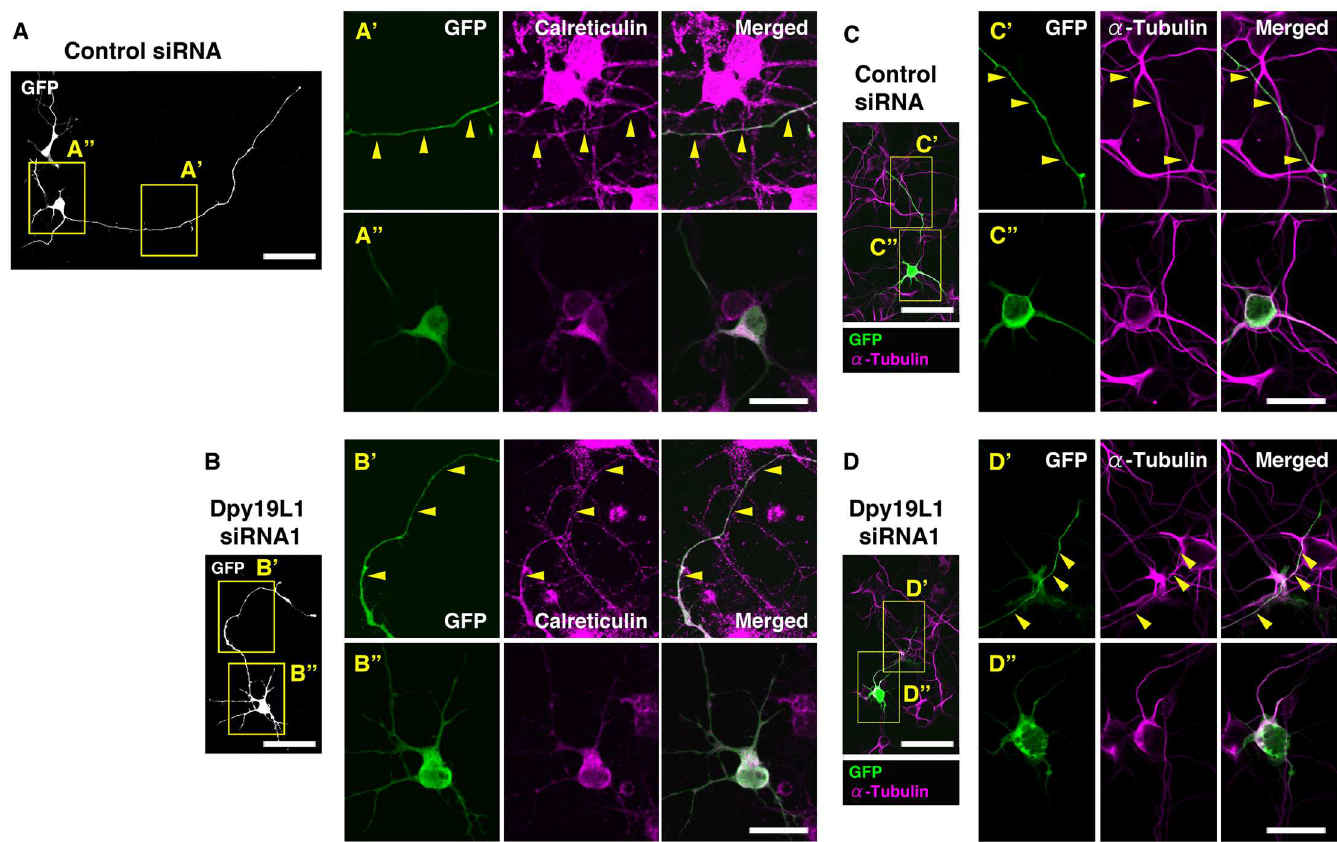
Fig 6. Distribution of Calreticulin in neurites of Dpy19L1-downregulated neurons. Either control siRNA (A and C) or Dpy19L1 siRNA1 (B and D) was transfected in embryoniccortical neurons. Cortical neuronswere allowedto differentiate for 72 h, subjectedto immunocytochemistry for GFP and Calreticulin (A and B), or for GFP and α -Tubulin(C and D). Boxed areas are magnifiedin A’-D”. Calreticulin, an ER marker, was observedin neurites of both control and Dpy19L1-downregulated neurons. Results shown are representative of at least three independent culture experiments. Scale bars: 50 μ m in A-D, 20 μ m in